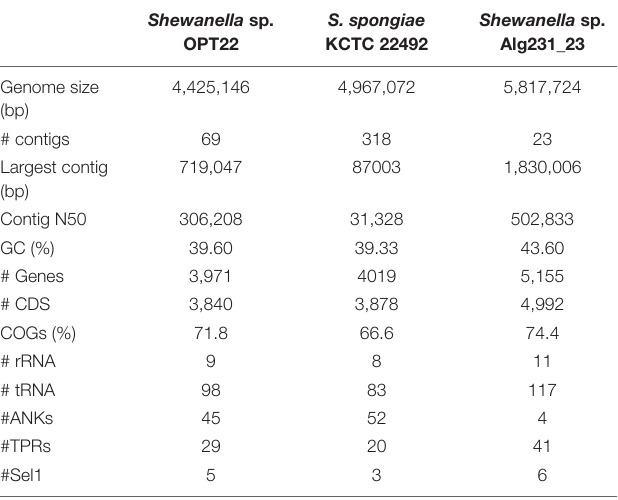
TABLE 2 | Genome characteristics of the three sponge-associated Shewanella species.